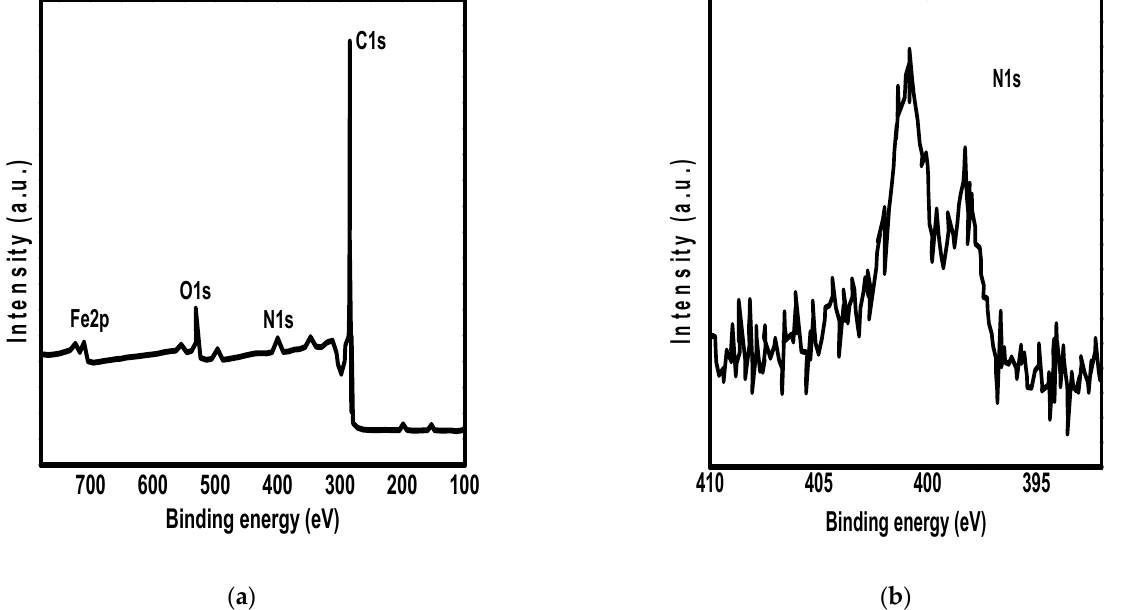
Figure 3. XPS full survey spectra ( a ) and survey for nitrogen ( b ) of the synthesized Fe 3 O 4 /N@C nanocomposite.